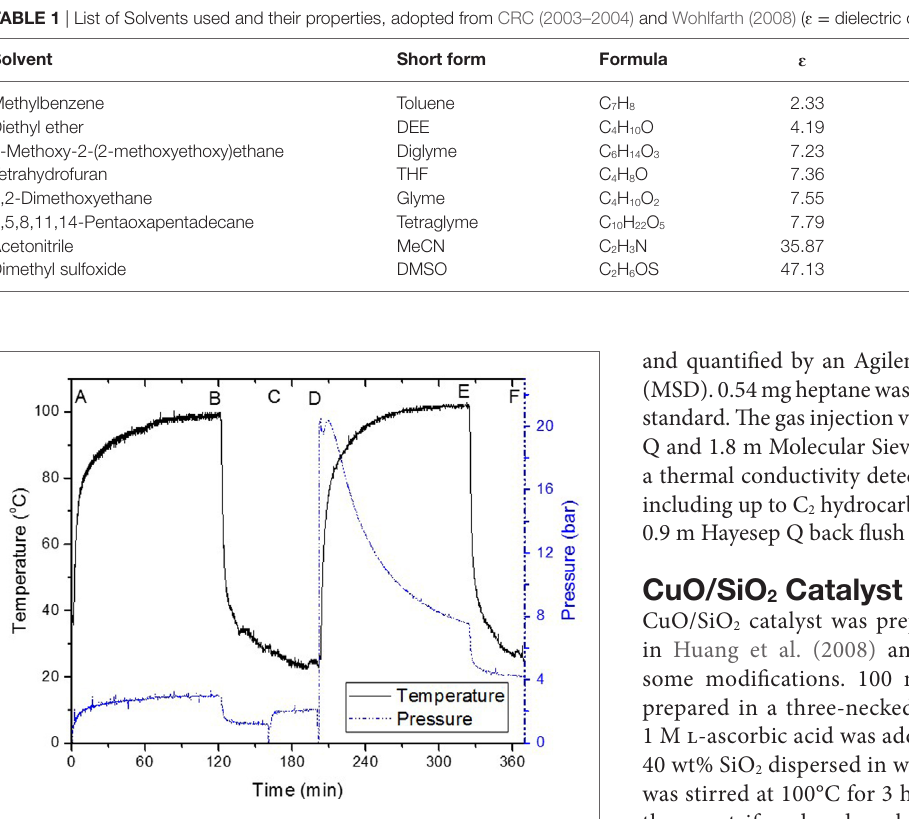
FigUre 1 | Typical “once through” low-temperature methanol synthesis reaction, (A) 3.6 mmol Cu(OAc) 2 + 18 mmol NaH in solvent, (B) rapid cooling in 50 ml solvent, (C) addition of 52 mmol MeOH, (D) 20 bar CO/2H 2 charging, (E) rapid cooling, (F) sampled for further analysis.